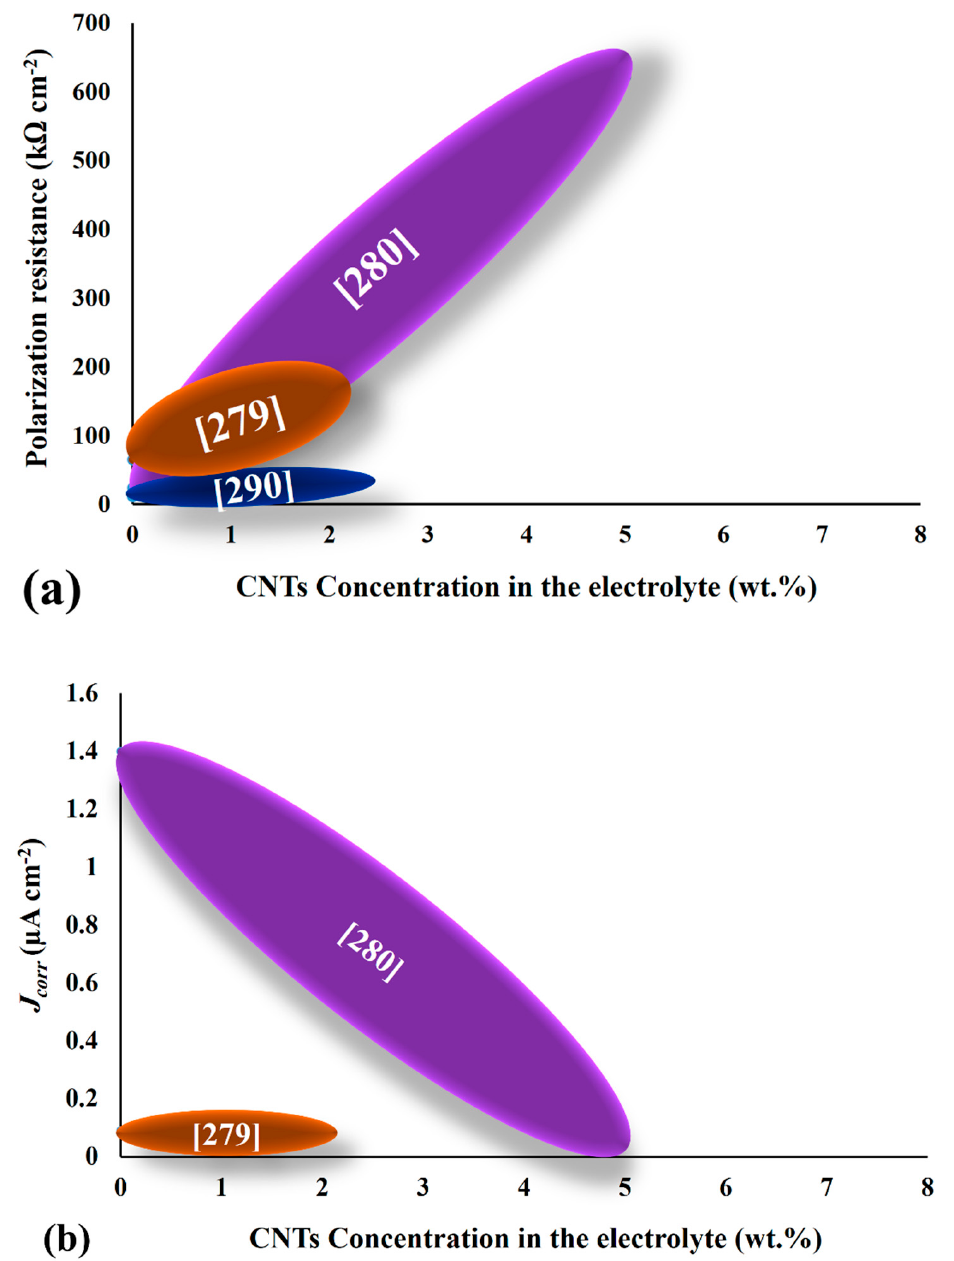
Figure 11. ( a ) R p and ( b ) j corr of HAp-CNTs composite coatings as a function of CNTs loadings in the electrolyte.